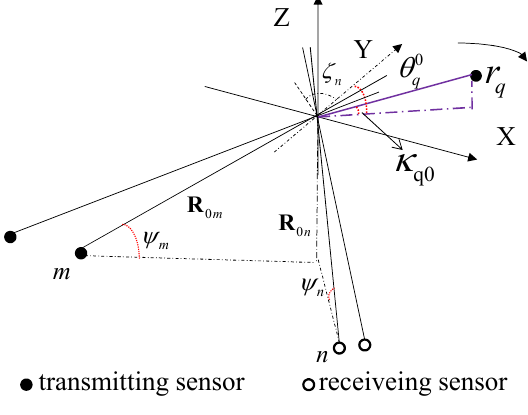
Figure 1. Geometry of the distributed